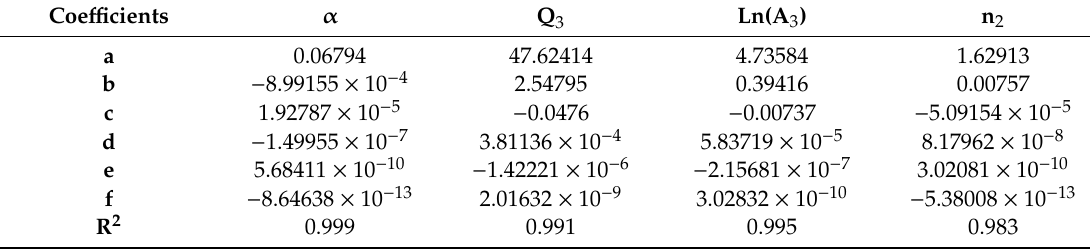
Table 1. The calculated coefficients in Equations (9)–(12).